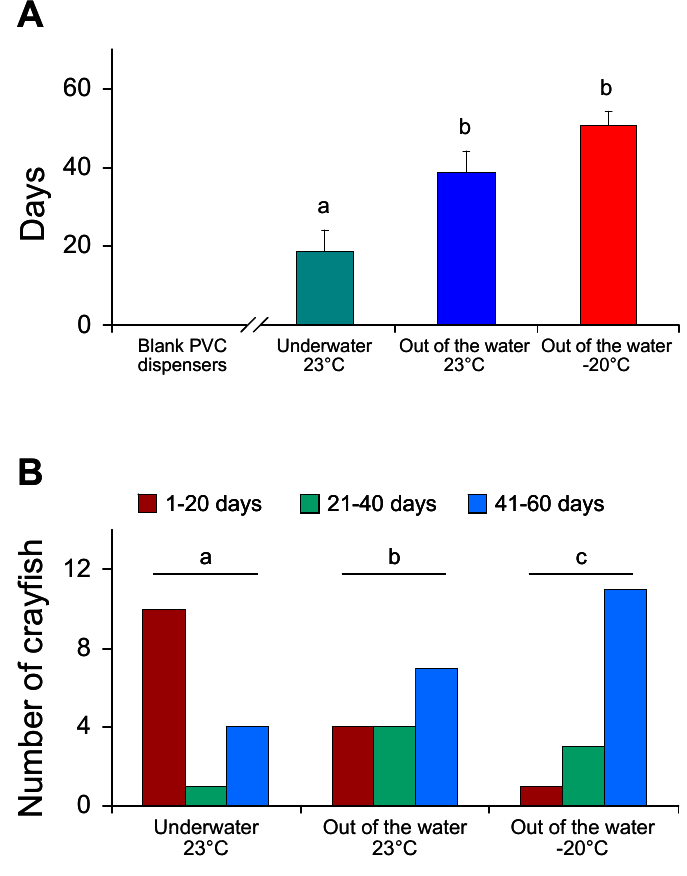
Figure 2. Attractiveness over time of the PVC/food dispensers stored under different conditions. ( A ) Mean values ± SE (vertical bars) of the days of attractiveness of the PVC/food dispensers stored underwater at 23 ◦ C and out of the water at 23 ◦ C or − 20 ◦ C. Data were obtained from 15 (eight females and seven males) crayfish. Bars followed by different letters are significantly different ( p < 0.05; Tukey test subsequent to repeated-measures ANOVA). ( B ) Distribution histograms of the number of crayfish ( n = 15) attracted by the PVC/food dispensers stored at the three different conditions for each of the three 20-day time intervals considered (1–20 days, 21–40 days and 41–60 days). Bars followed by different letters are significantly different ( p < 0.05; Kolmogorov-Smirnov test (two sample K-S